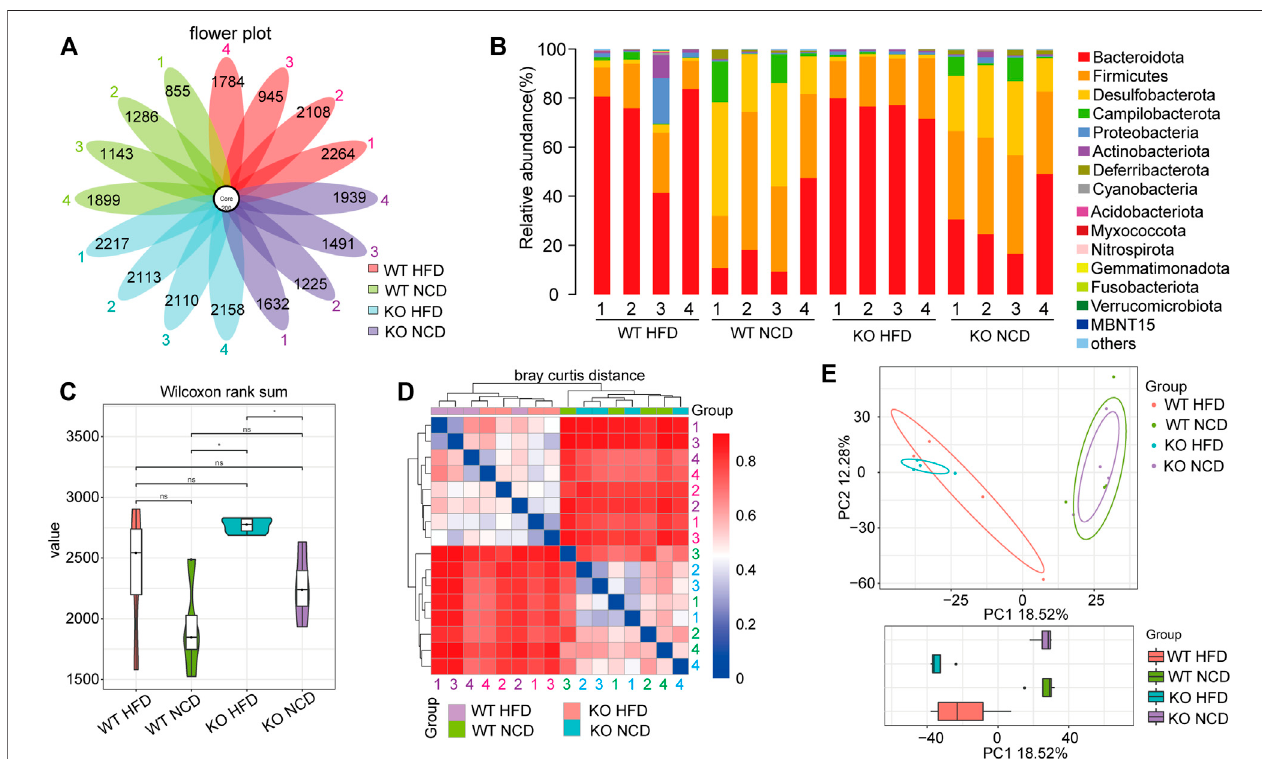
FIGURE 7 | Microbiome analyses were performed using cecal samples. (A) Venn diagram showing the distribution of operational taxonomic units (OTUs). The numbers in the center represent the OTUs common to all samples (i.e., Core OTUs), and the numbers on the petals represent the total OTUs of each sample minus the number of OTUs common to all samples. (B) The microbial community structure in each sample. The relative abundance is colored in shades of yellow (low relative abundance) to red (high relative abundance). (C) Alpha diversity analysis among groups. (D) Beta diversity index heatmap in four groups. (E) Principal component analysis (PCA) 2D-plot of individuals showing the difference among multiple